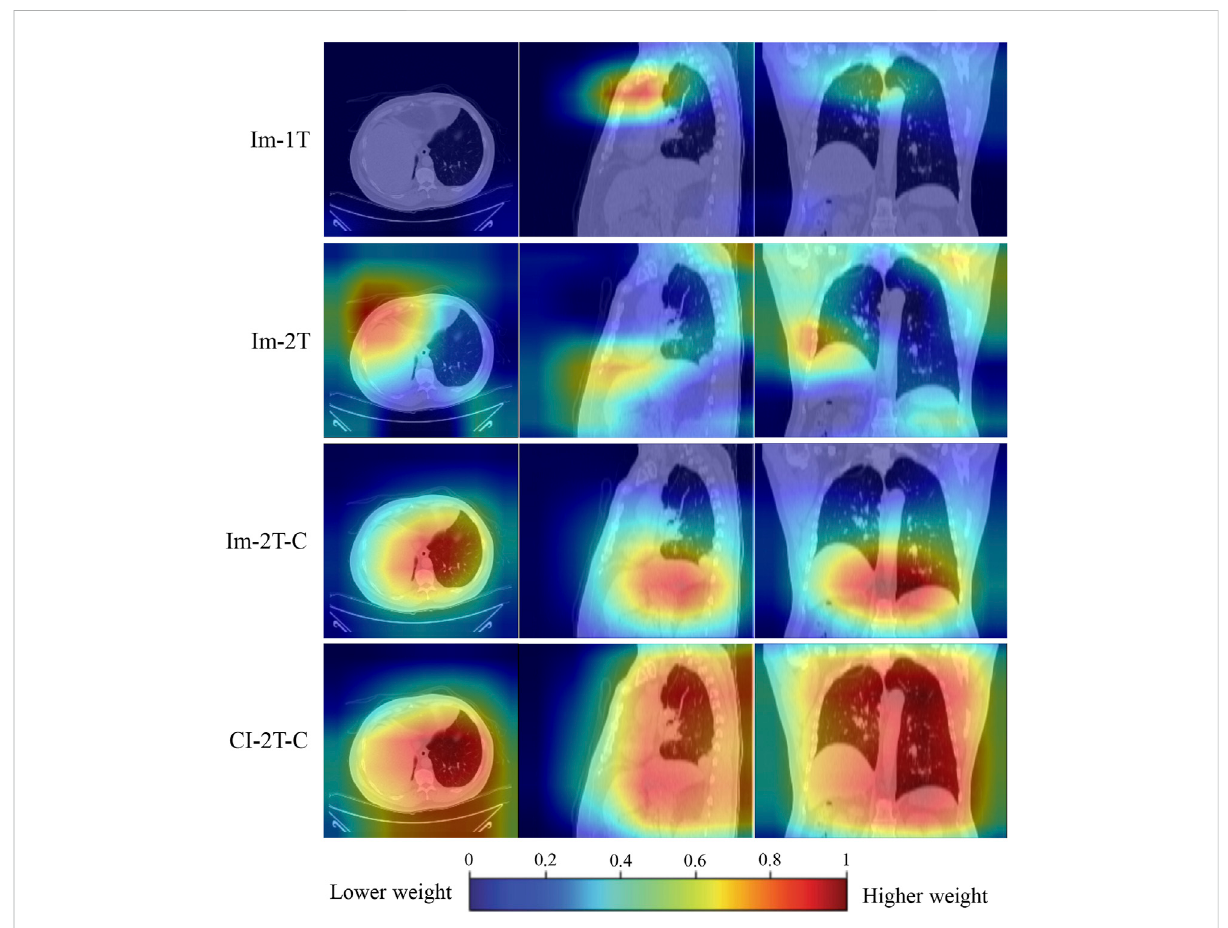
FIGURE 7 Activationmapsforanon-ICIPsampletoshowthemost “ important ” regionsthatdifferentmethodsconsider.Theredcolorrepresentsahigher weight (i.e., more attention is paid to this